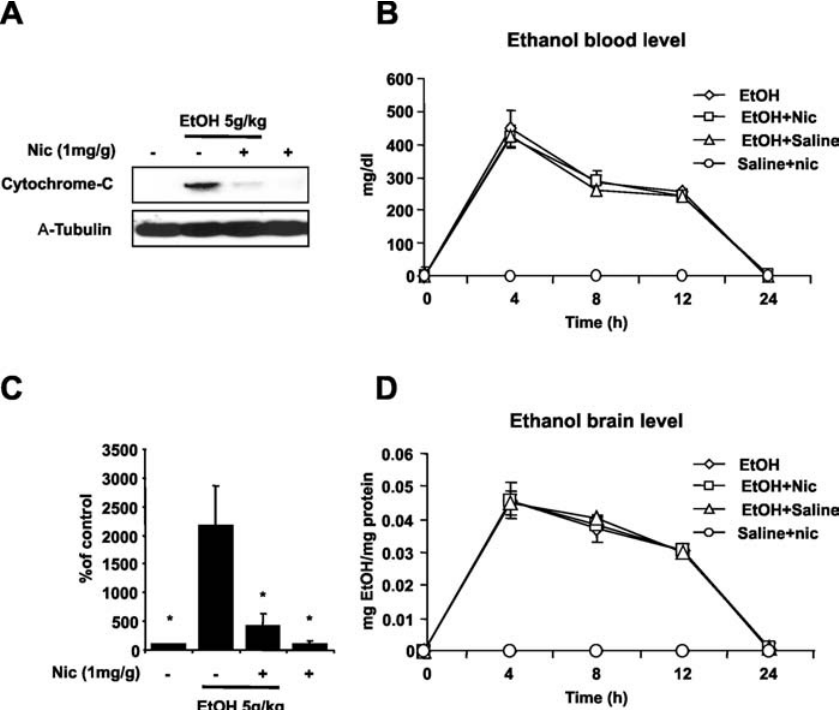
Figure 2. Nicotinamide Blocks Release of Cytochrome-C from Mitochondria (A) Western blot analysis of cytochrome-c release in the cytosolic fraction 12 h after ethanol administration. (C) Densitometric quantification of cytochrome-c release (ANOVA F 3,20 ¼ 43.546 p , 0.0001; n ¼ 6 each treatment group). Values are shown as mean 6 SD. Bonferroni correction for multiple comparison revealed a significant difference between ethanol treatment group and all other groups. (cid:2) p , 0.0001. (B and D) Nicotinamide (1mg/g) does not alter ethanol absorption or excretion. Ethanol levels in blood (B) and brain (D) were measured at different time points after 5g/kg of ethanol treatment in P7 mice. Nicotinamide was administered 2 h after ethanol exposure. No significant differences were seen between the different treatments ( n ¼ 4 each treatment group). DOI: